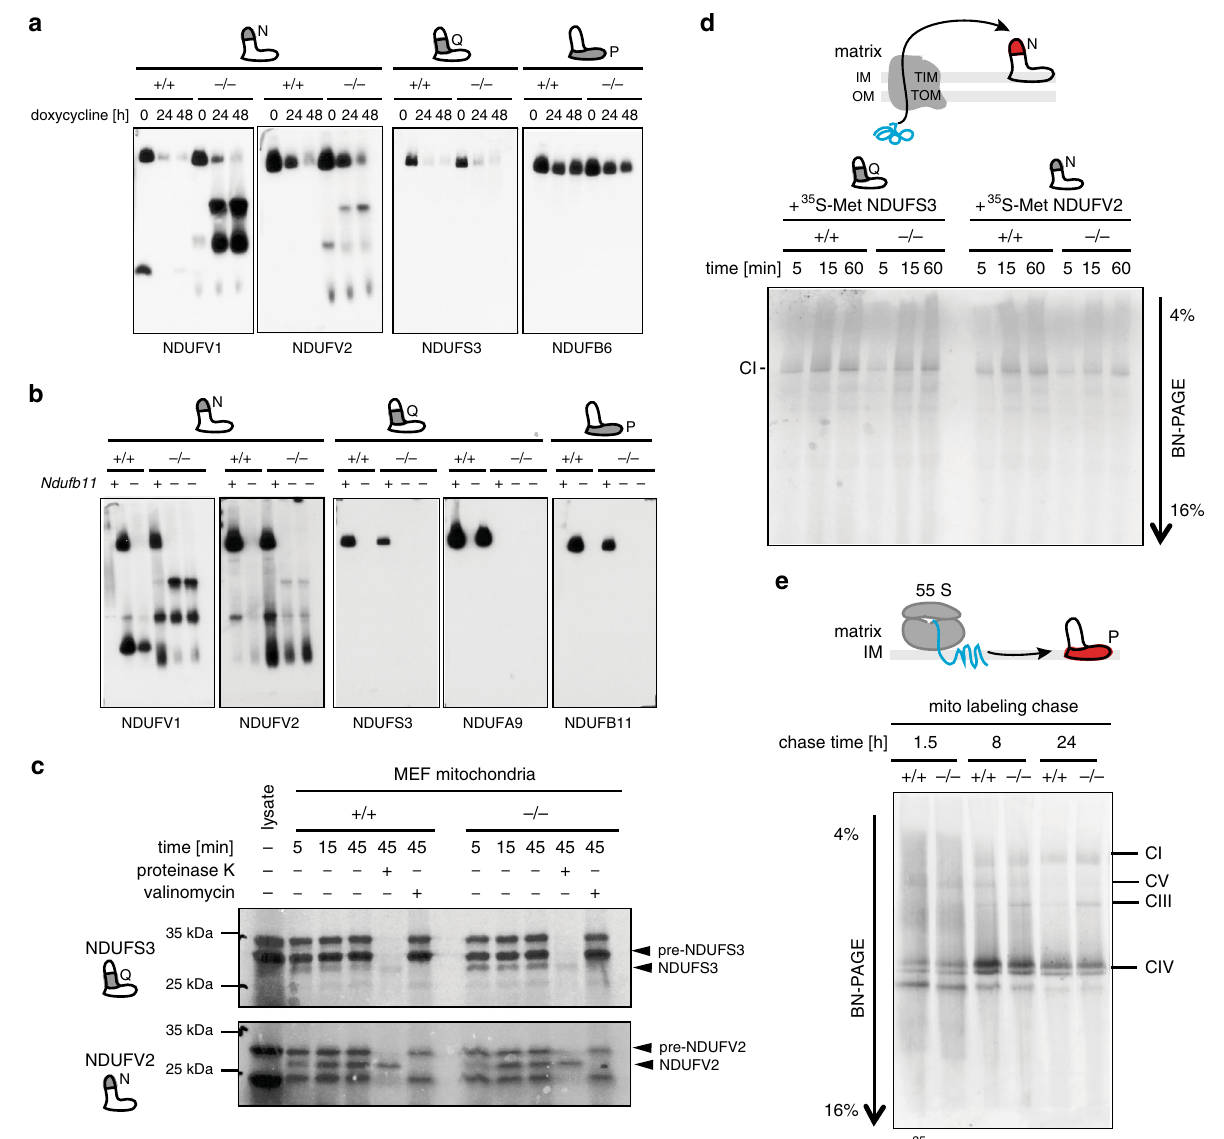
Fig. 2 ClpXP protease regulates the turnover of N-module. a Time-lapse BN-PAGE followed by western blot analysis of CI pro fi les in wild type ( + / + ) and CLPP-de fi cient ( − / − ) MEFs upon acute respiratory chain disruption via doxycycline-mediated inhibition of mitochondrial protein synthesis ( n = 3). b BN- PAGE followed by western blot analysis of CI in wild type ( + / + ) and CLPP-de fi cient ( − / − ) cells upon CRISPR/Cas9 depletion of NDUFB11 subunit ( n = 3). c Import of radiolabeled precursors (pre-) of CI subunits into wild type ( + / + ) and CLPP-de fi cient ( − / − ) mitochondria isolated from MEFs ( n = 4). d Import of radiolabelled NDUFV2 and NDUFS3 precursors and subsequent incorporation into Complex I in intact heart mitochondria from wild type ( + / + ) and CLPP-de fi cient ( − / − ) animals. After the indicated incubation times mitochondrial complexes were analyzed by BN-PAGE ( n = 4). e Pulse labeling ( 35 S-methionine) of mtDNA-encoded subunits in wild type ( + / + ) and CLPP-de fi cient ( − / − ) MEFs followed by chases for indicated time points. Mitochondrial complexes were analyzed by BN-PAGE ( n = 3). Antibodies used were raised against proteins indicated in the Figure, with putative CLPP substrates shown in bold. “ n ” represents number of biologically independent